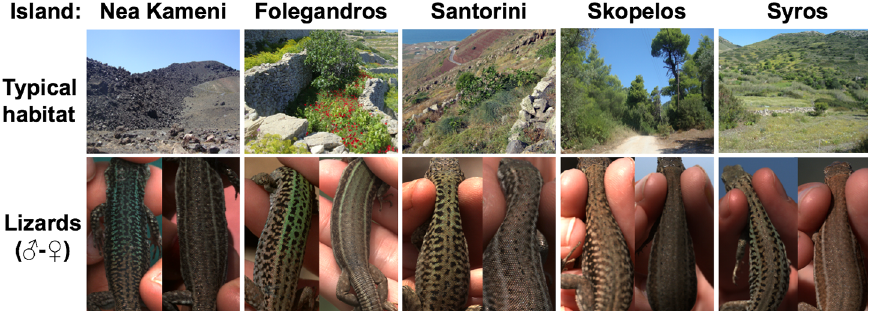
Fig 1. Example images of Aegean wall lizards ( Podarcis erhardii ) and their typical island habitats. Images depict typical natural habitat and dorsal coloration of males (left image) and females (right image) in each focal island population (Nea Kameni, Folegandros, Santorini, Skopelos and Syros). Images were obtained in the field by the